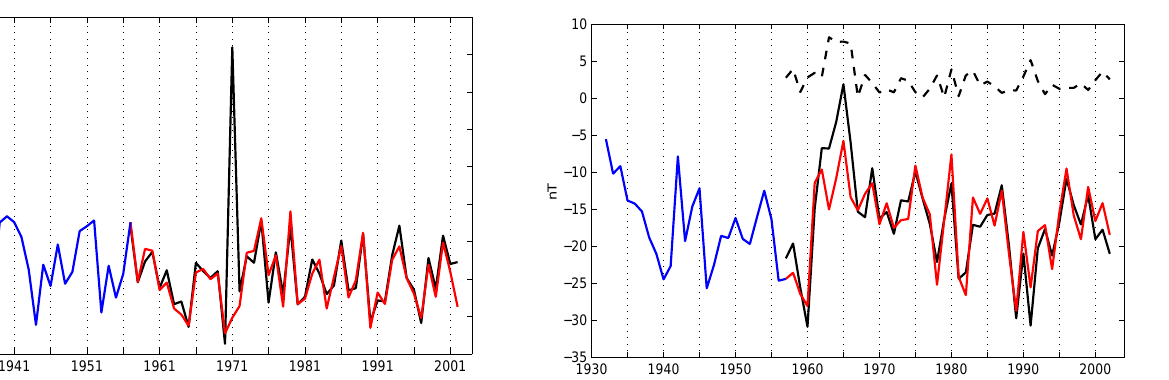
Fig. 5. Annual average value of the reconstructed D st in 1932–1956 (blue), in 1957–2002 (red) and of the original D st in 1957–2002 (black). The absolute difference between the original and recon- structed D st in 1957–2002 is depicted as a dashed line. All hourly values were